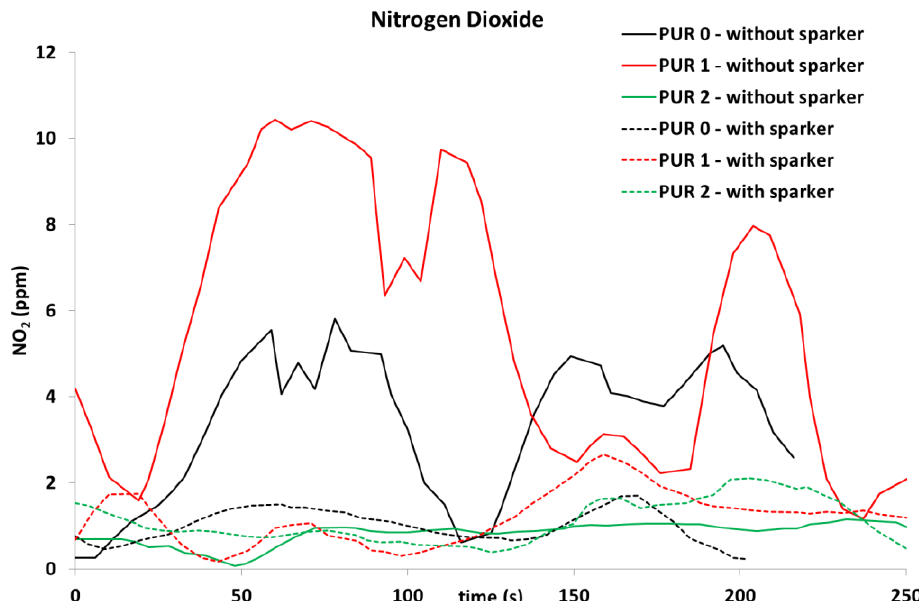
Figure 13. Nitrogen dioxide release, during exposure of the PURs to the 40 kW/m 2 of heat flux; self-ignited and ignited with a spark igniter.